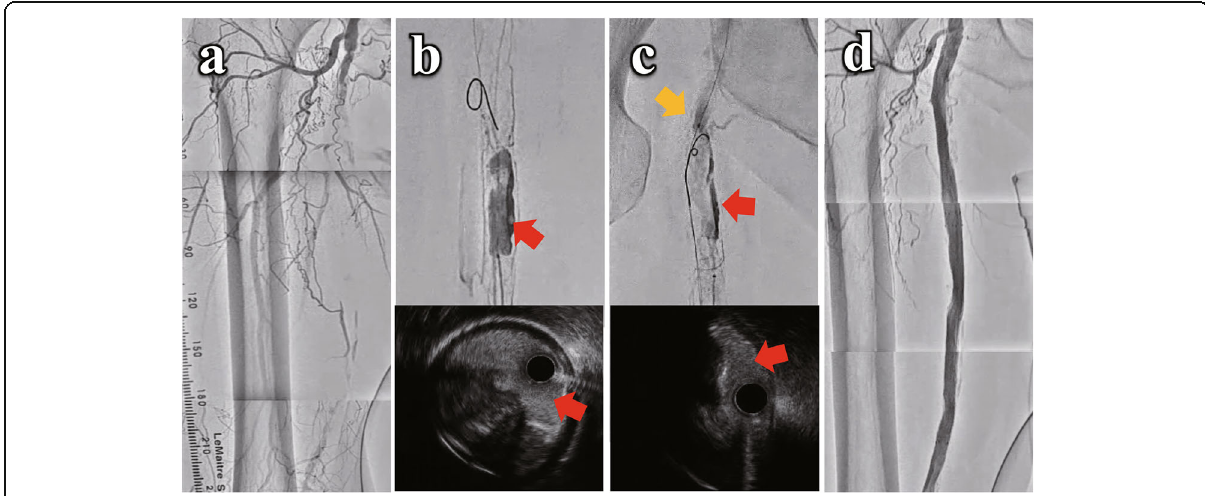
Fig. 2 Angiography and intravascular ultrasound (IVUS) of superficial femoral arterial occlusion treatment with the “ DIOL ” fashion in case 1. A Control angiography of right superficial femoral arterial occlusion. B After conventional bidirectional wiring failed, retrograde-DIOL with a forceful tip injection from the retrograde microcatheter revealed a tubular dissection with a vessel road (red arrow). C Reverse controlled antegrade and retrograde tracking and dissection (CART) and re-entry failed. Retrograde-DIOL was reperformed to expand the subintimal lumen (red arrow). DIOL contrast penetrated into the proximal lumen and the branch (orange arrow). D After two drug-eluting stents deployment, a satisfactory result was